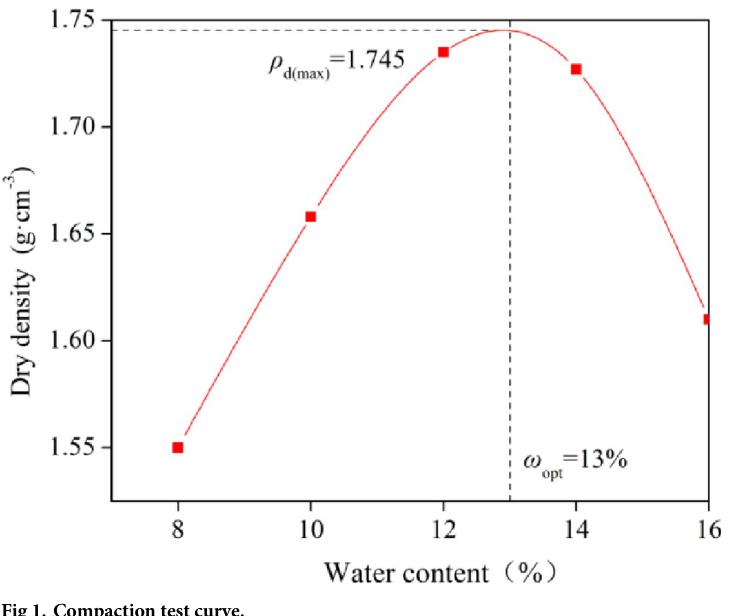
Fig 1. Compaction test curve.